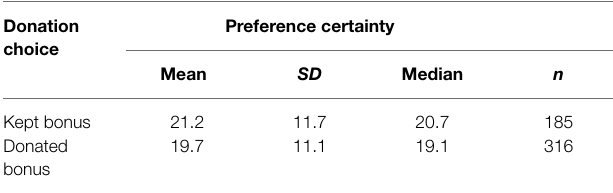
TABLE 1 | Distributions of preference certainty scores, grouped by donation choice. Donation